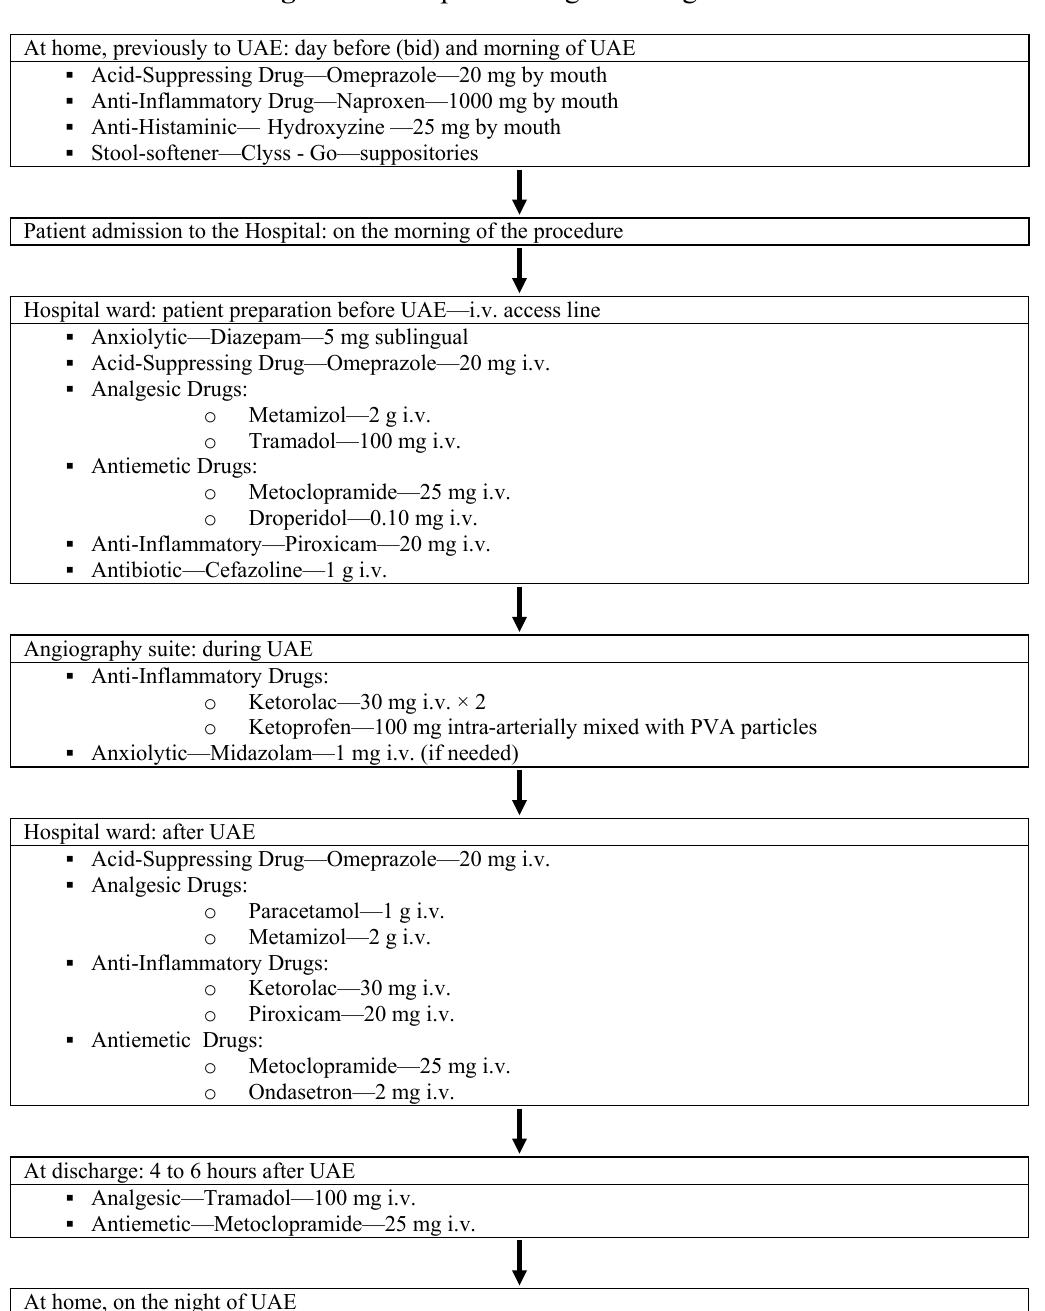
Figure 1. UFE pain management